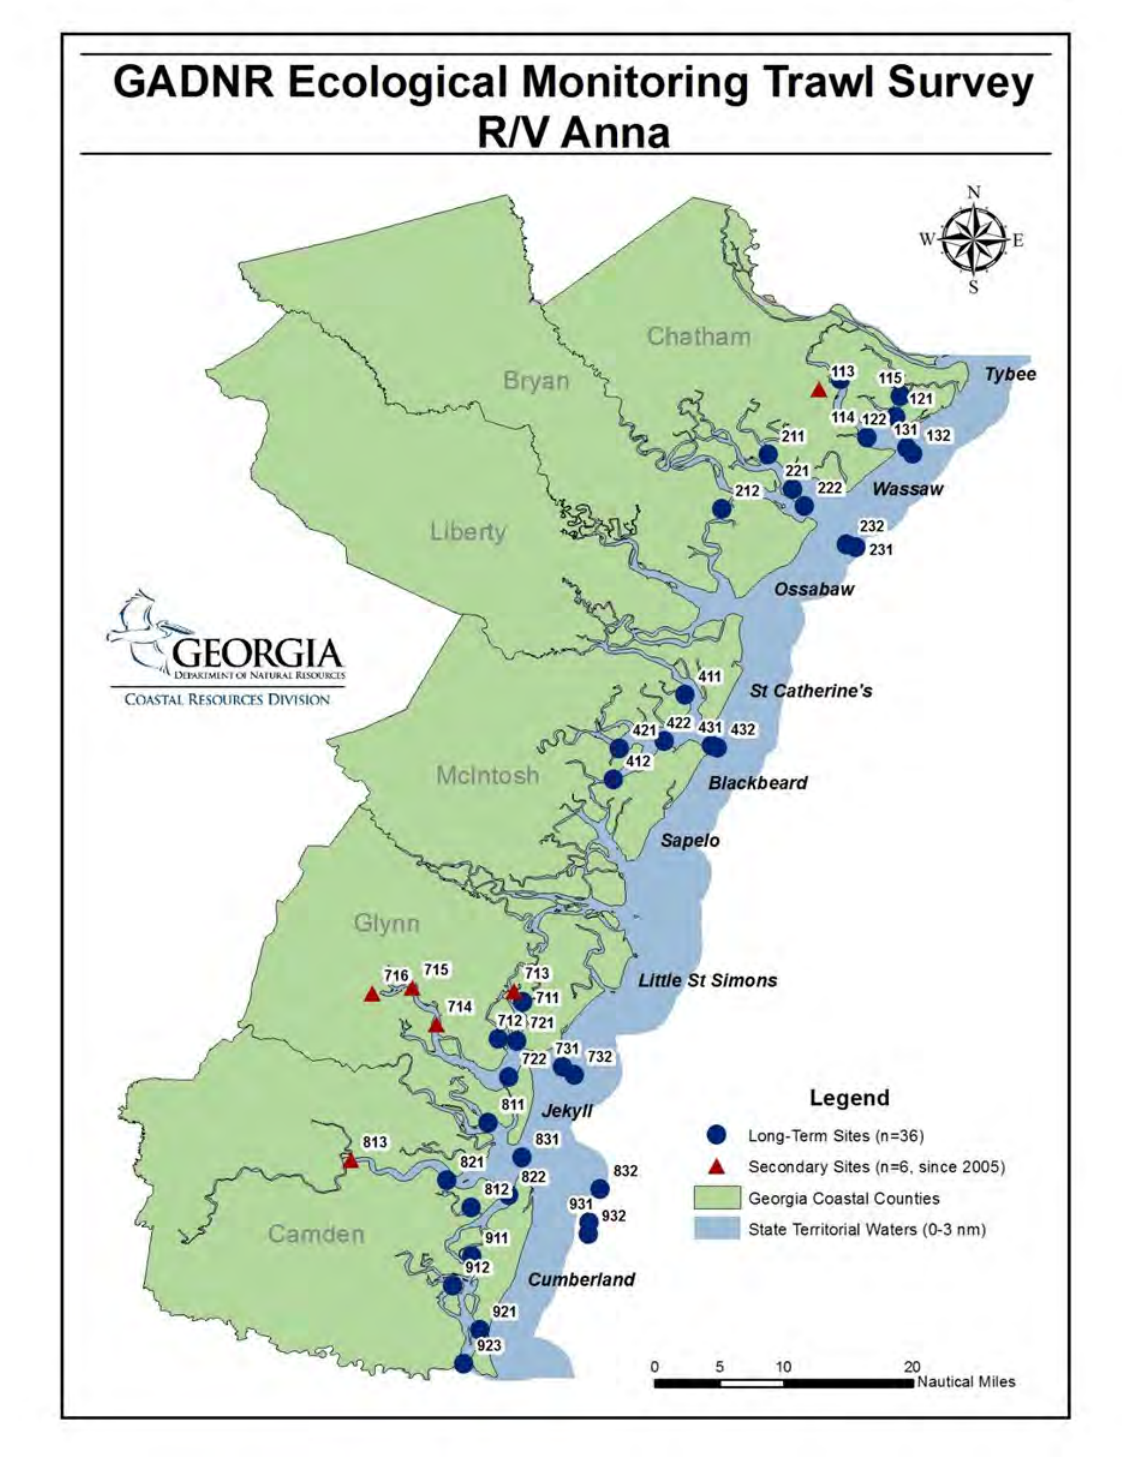
Figure 71. Map of the survey sites for Georgia’s Ecological Monitoring Trawl Survey (map provided by GA